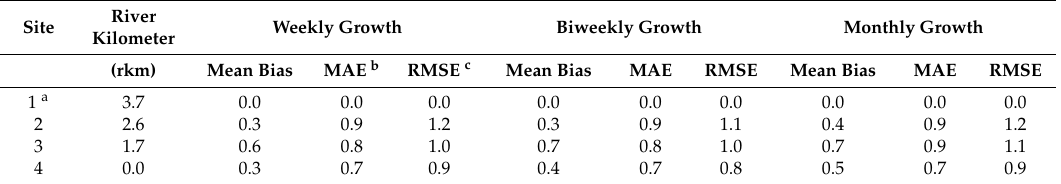
Table 3. A summary of performance results for each simulation of water temperatures given various frequencies of interpolated canopy growth. All performance metrics are measured in °C.